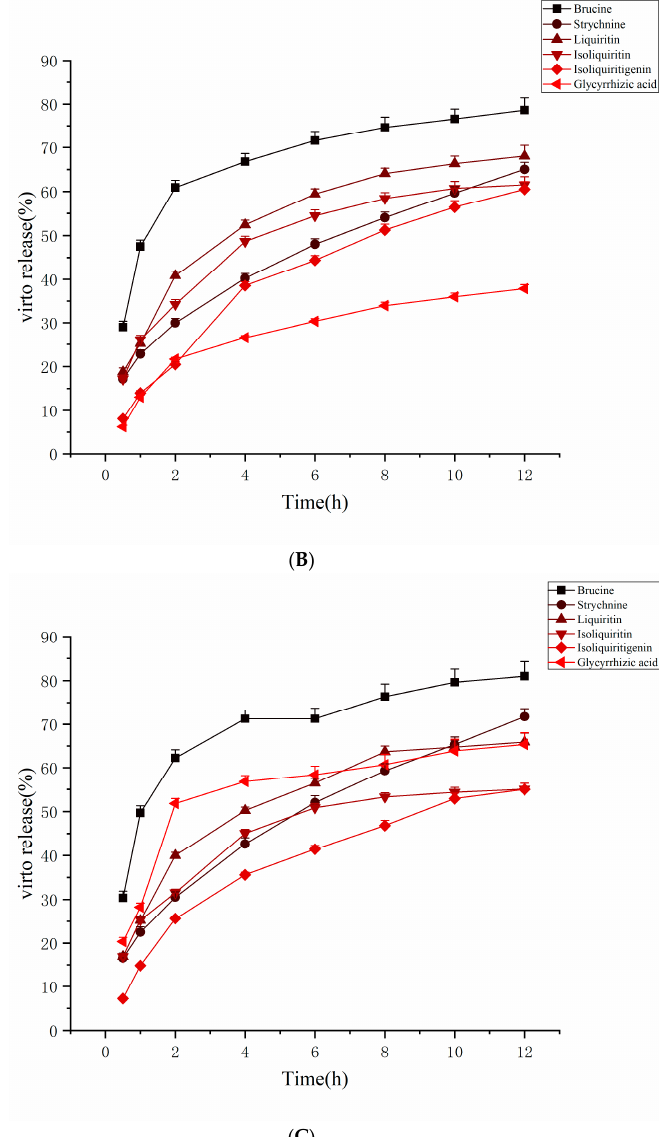
Figure 4. The release curve of the dissolution media; ( A ) distilled water; ( B ) artificial intestinal fluid; ( C ) artificial gastric juice. Table 4. Percentage of cumulative release in distilled water (mean ± SD, %). Component